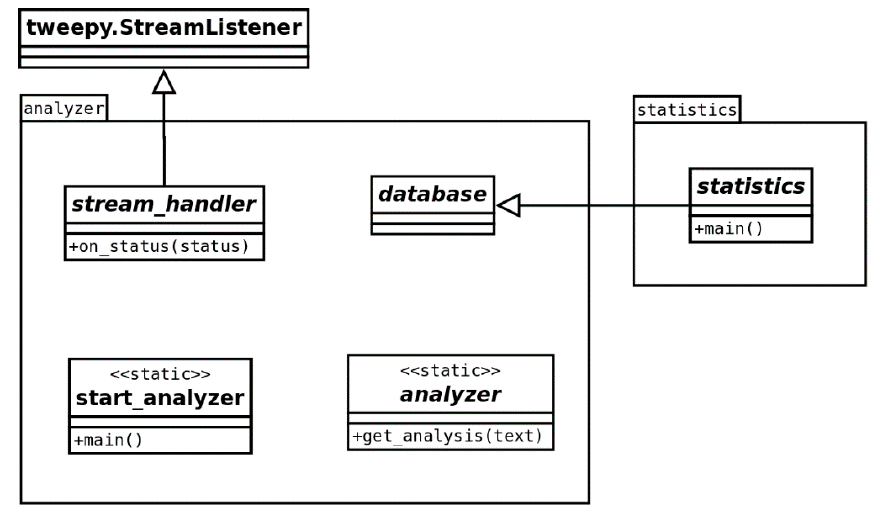
Figure 1. Static classes and scripts used in the project.